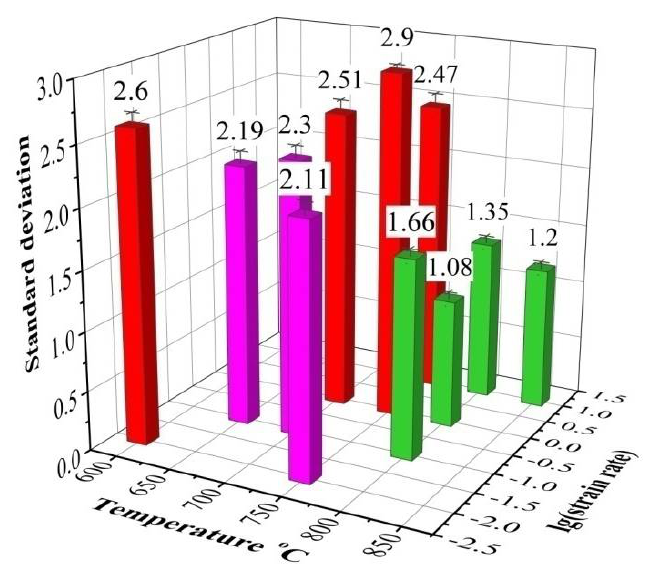
Figure 9. Standard deviation of grain size .